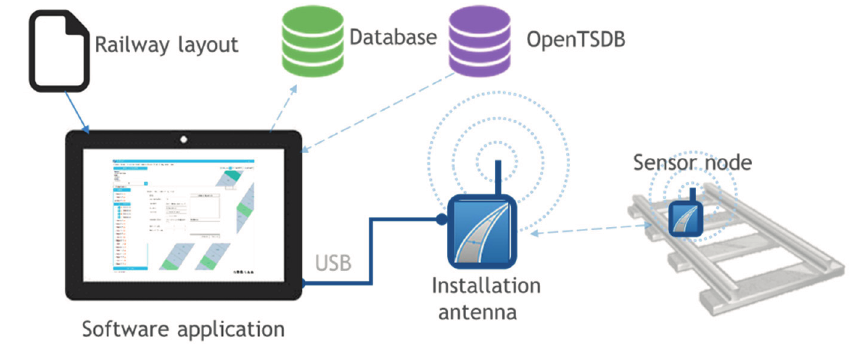
Figure 3. Installation phase communication architecture.